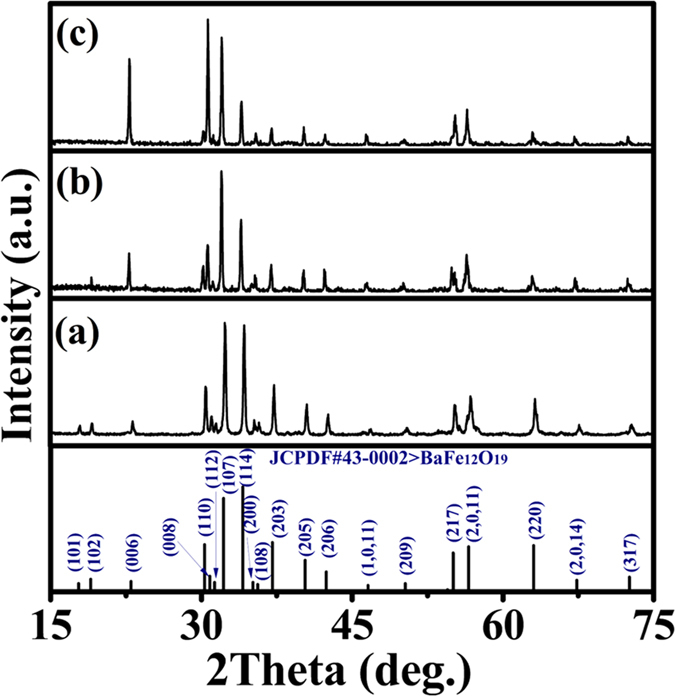
The X-ray diffraction patterns for Ba1−xLaxFe12O19 samples.(a) x = 0.0, (b) x = 0.5, (c) x = 1.0. And the main (hkl) peaks from JCPDF Card No. 43–0002 for BaFe12O19 are also plotted.